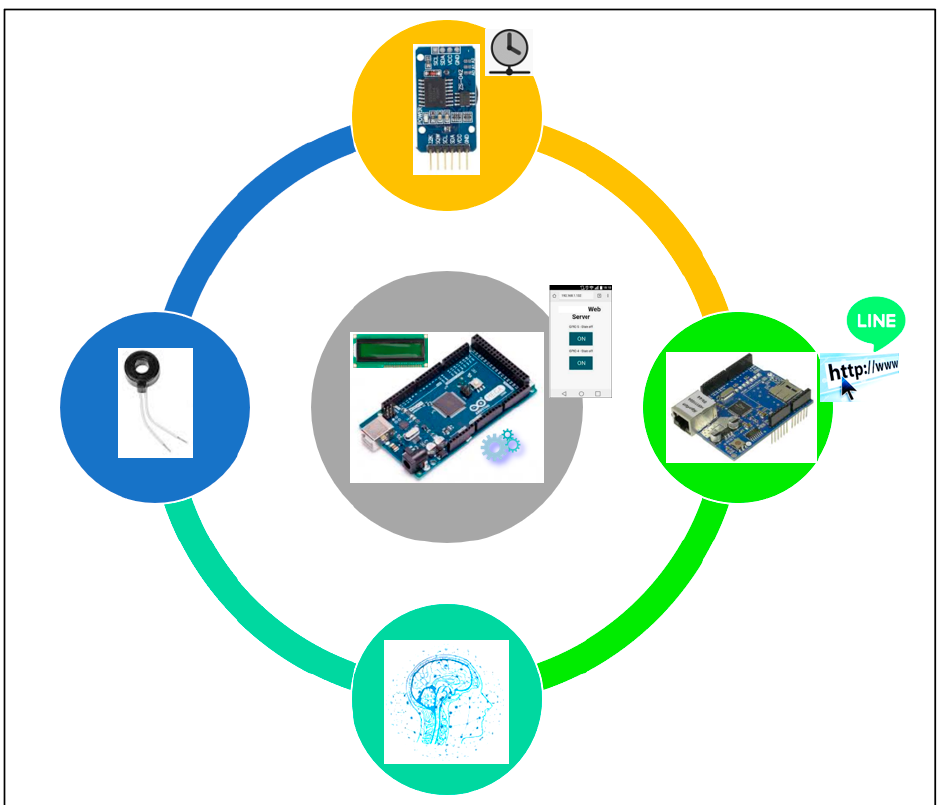
Figure 5. Presented smart AI across IoT (AIoT) edge analytics-empowered power meter prototype. The current sensor-based prototype is based on Arduino MCU providing a push notification service. Table 1. Technical specification of Arduino MEGA 2560